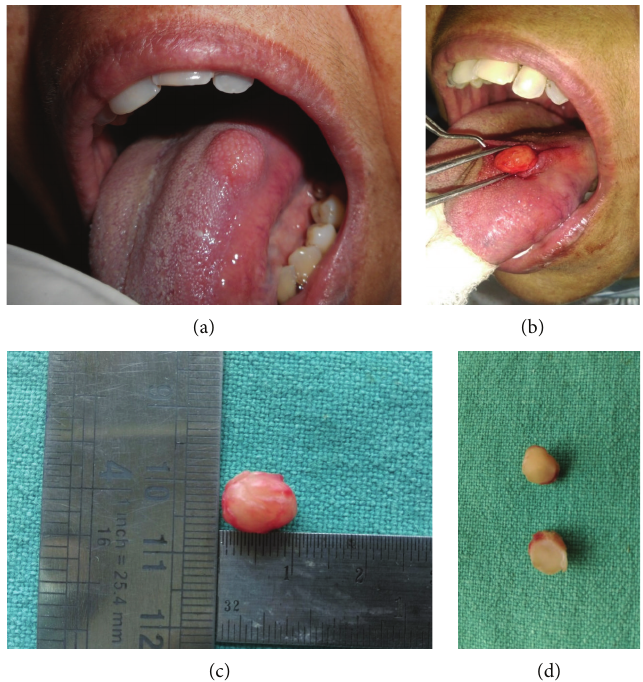
Figure 1: (a) Intraoral photograph showing well-circumscribed round 1.0cm × 1.0cm nodule over dorsum of tongue near left lateral border. (b) Peroperative photograph showing well-circumscribed tumor separated from the surroundings through blunt dissection. (c) Gross specimen appearing well-circumscribed, yellowish white, and oval and measuring 10.0mm × 5.0 mm × 5.0 mm. (d) Cut surface of the excised tumor appearing homogenous, white, and firm without haemorrhage or